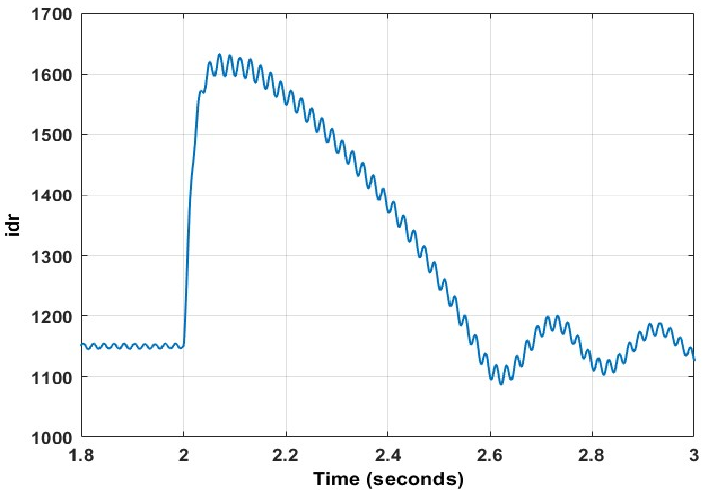
Figure 22. DC voltage transient using PI at 70% dip.